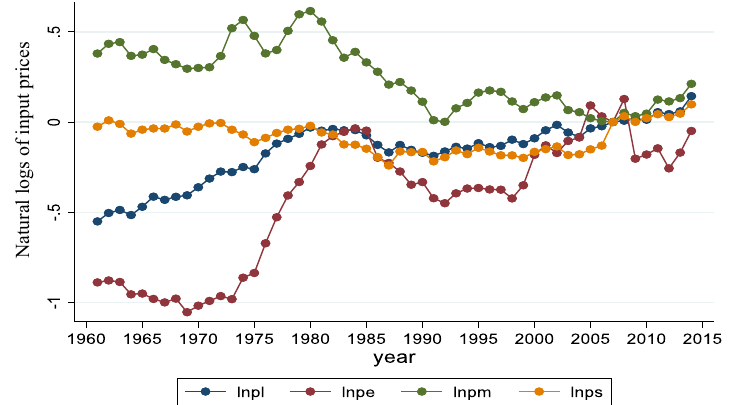
Number of observations is 54 (1961–2014). The variable cost and input prices are deflated using the outprice index. Output and Capital inputs are indexes